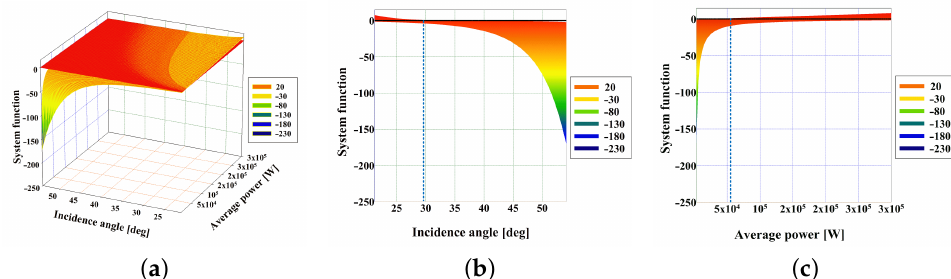
Figure 11. ( a ) When the number of multi-looks, satellite height, and scale factor of water ice are L look = 10, H sat = 100 km and 10%, the system function changes with the incidence angle φ and average power P av . ( b , c ) are the simulation results of the system function changing with φ and P av , respectively.